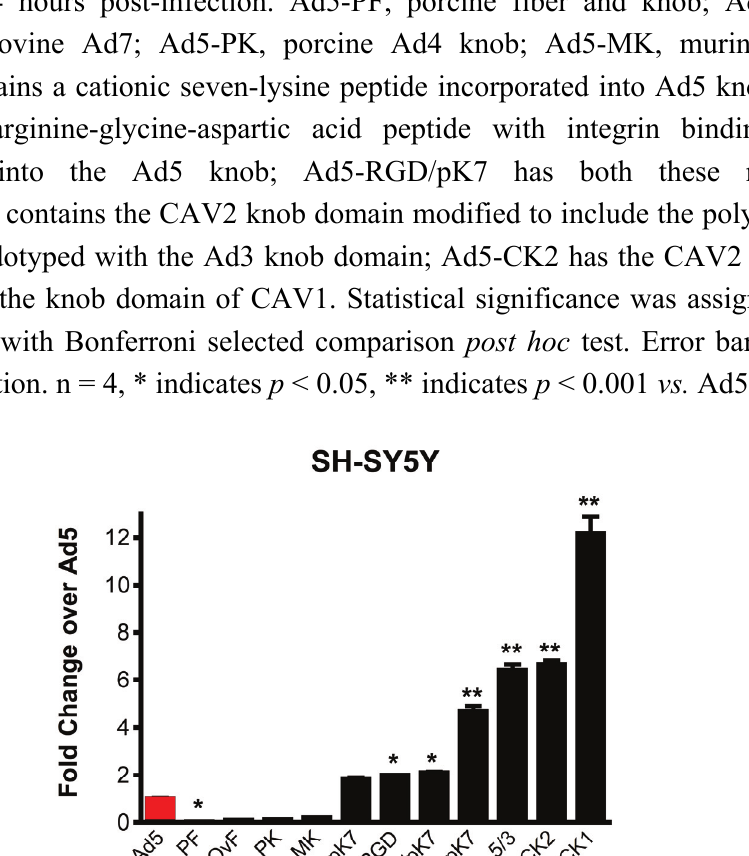
Figure 2. Ad5 vector gene transfer in dopaminergic cells. Luciferase reporter gene activity following transduction of SH-SY5Y human neuroblastoma cells with 10 viral